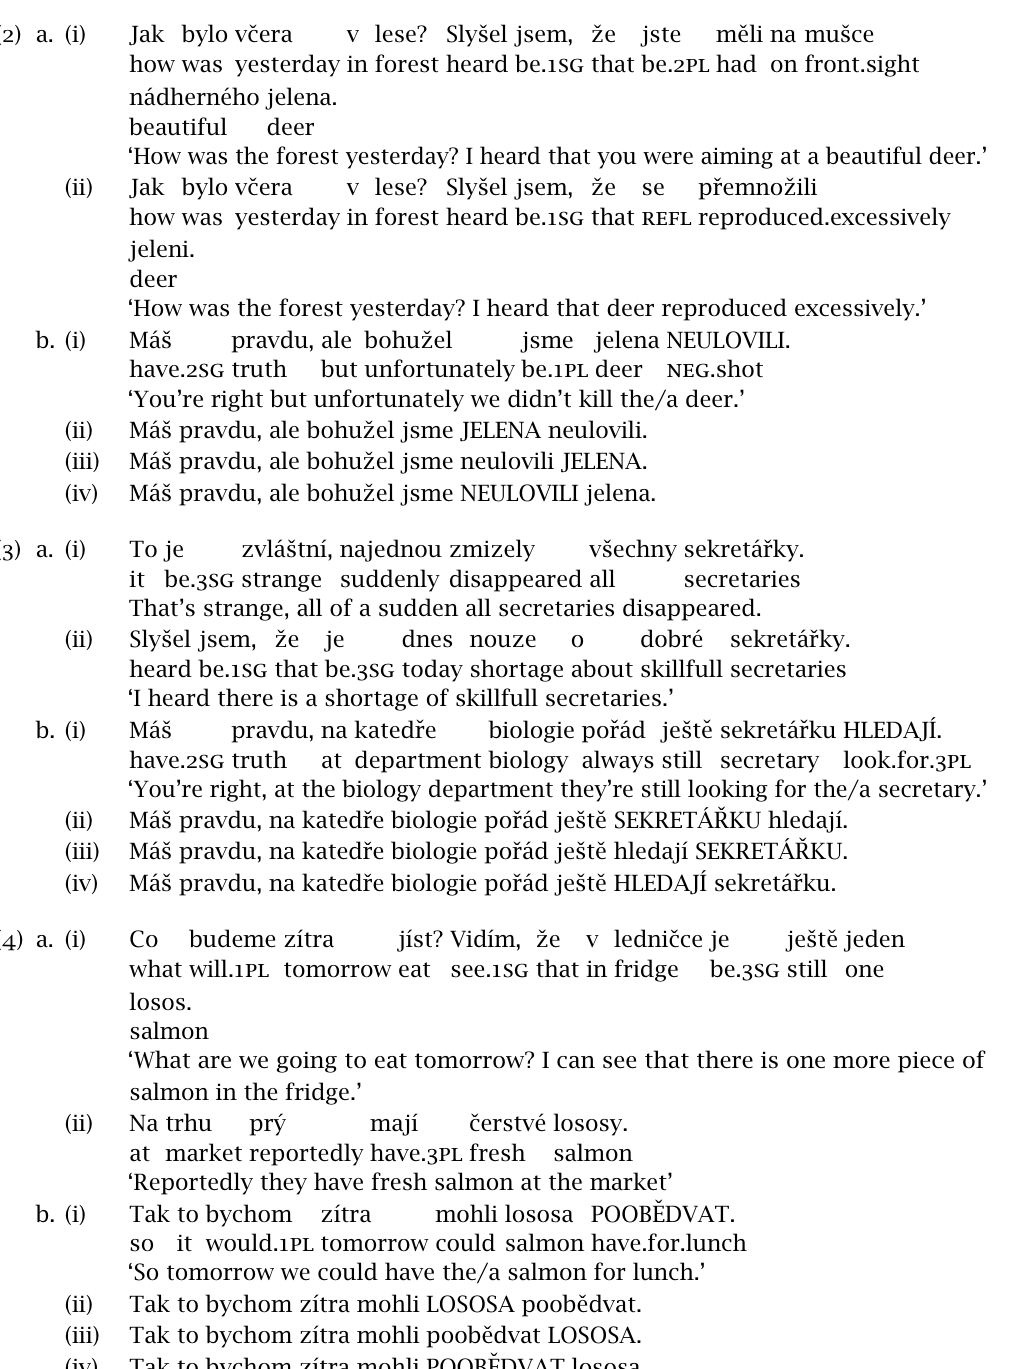
Tak to bychom zítra mohli POOBˇEDVAT